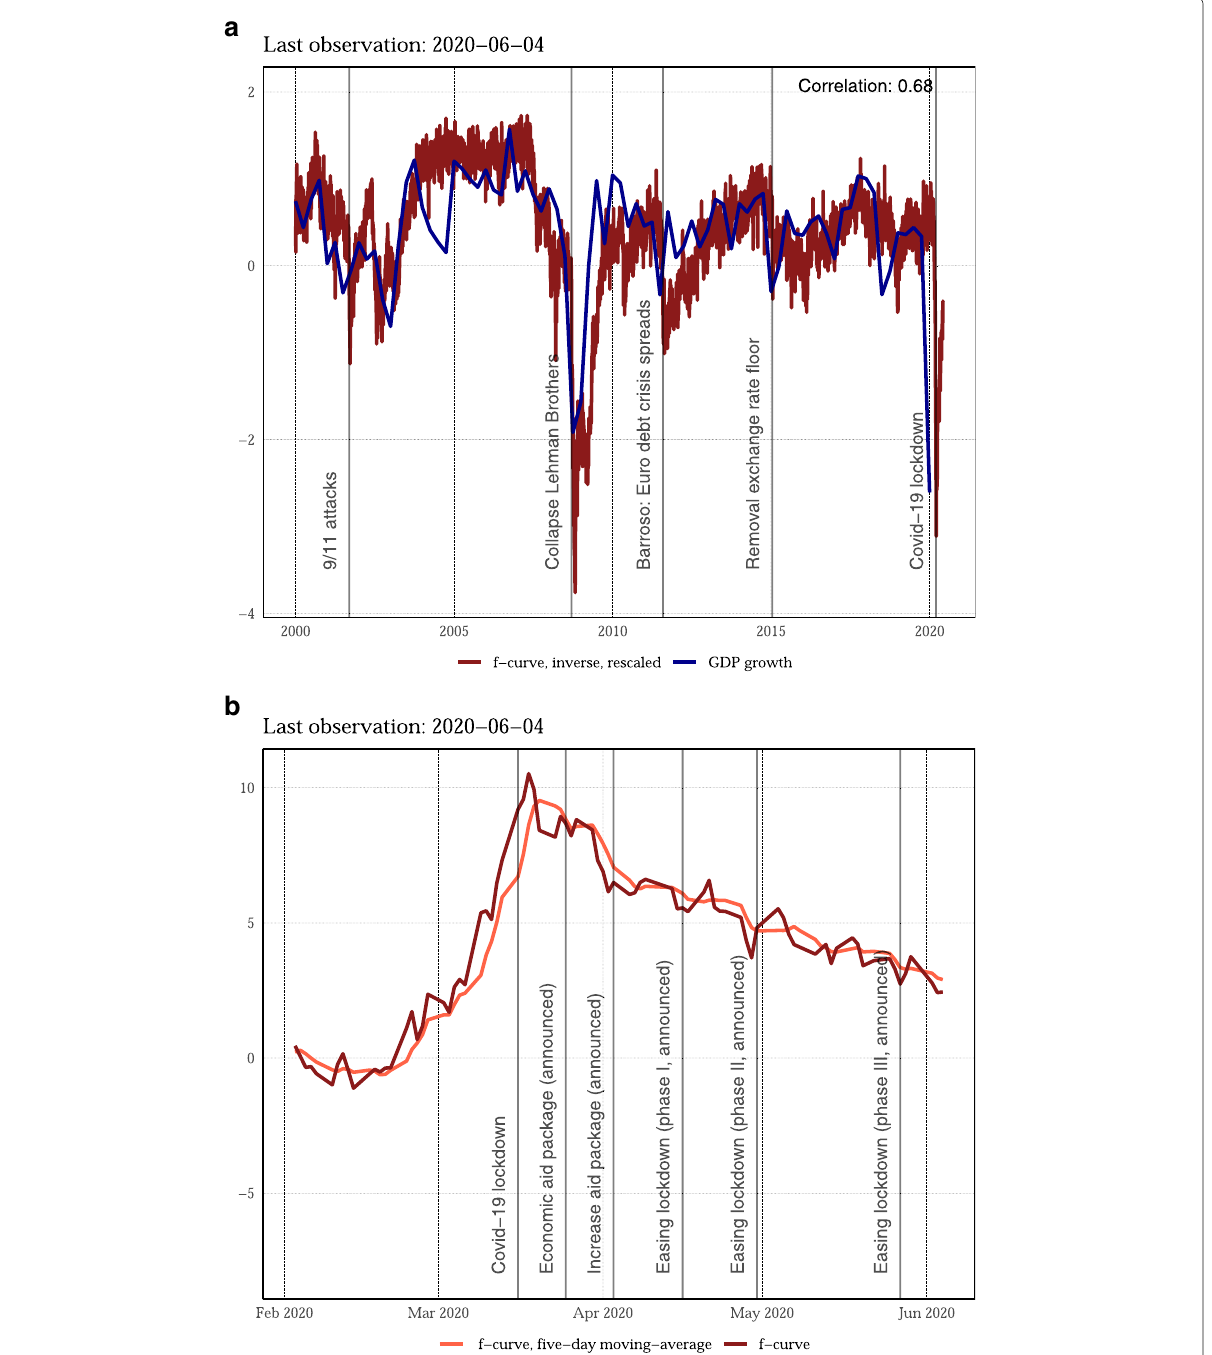
Fig. 1 A fever curve for the Swiss economy. Panel a compares the fever curve (inverted and rescaled) to quarterly GDP growth. Panel b panel gives daily values of the fever curve along with important policy